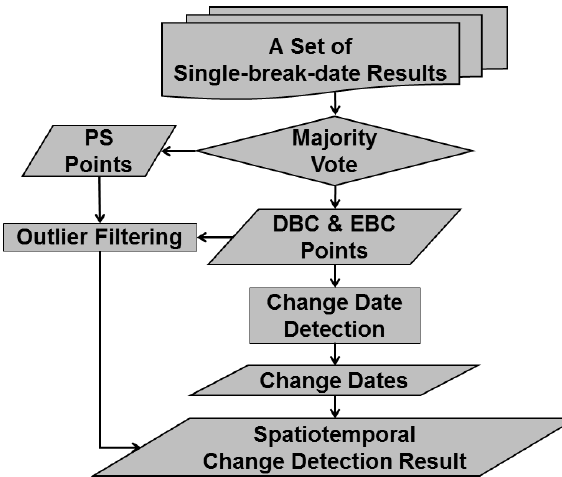
Figure 3. Flowchart of multi-break-date change detection.